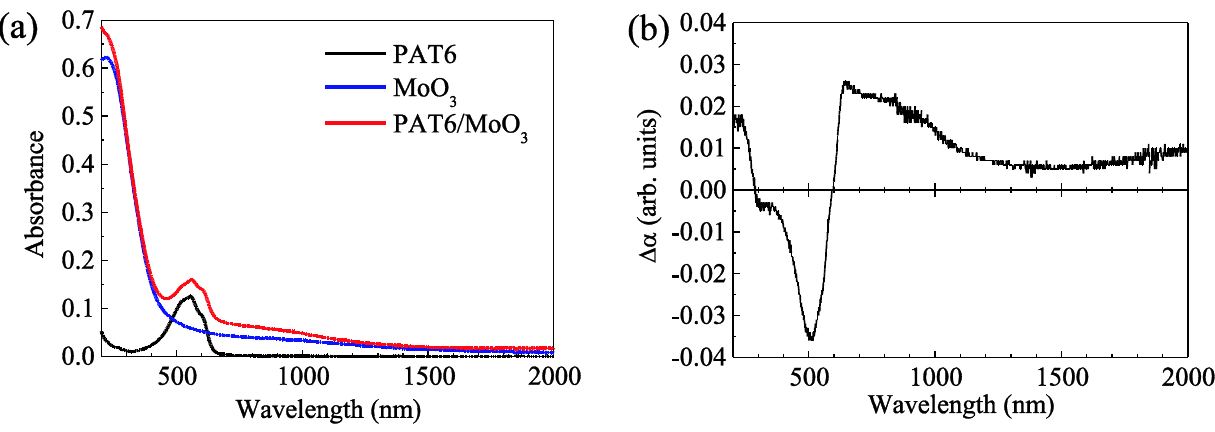
Figure 5. ( a ) UV-VIS-NIR absorbance spectra of the PAT6 film, MoO PAT6/MoO bi-layer, film and ( b ) differential absorption 3